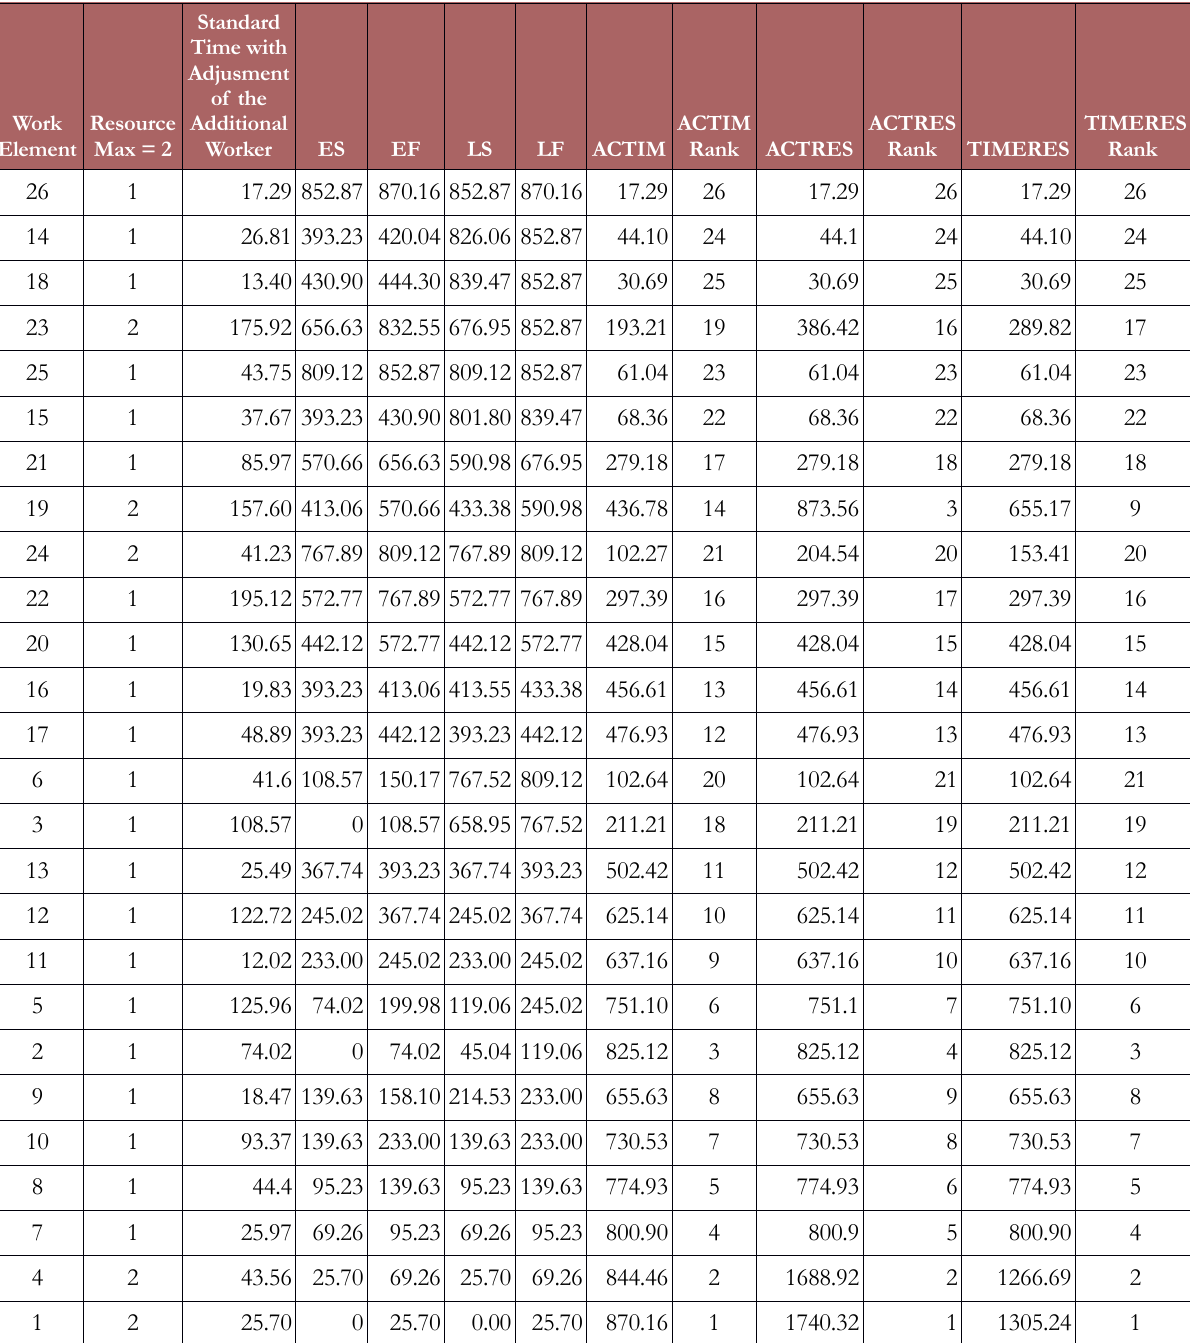
Table 8. Calculation of ES, LS, EF, LF, ACTIM, ACTRES, and TIMRES for Rmax =